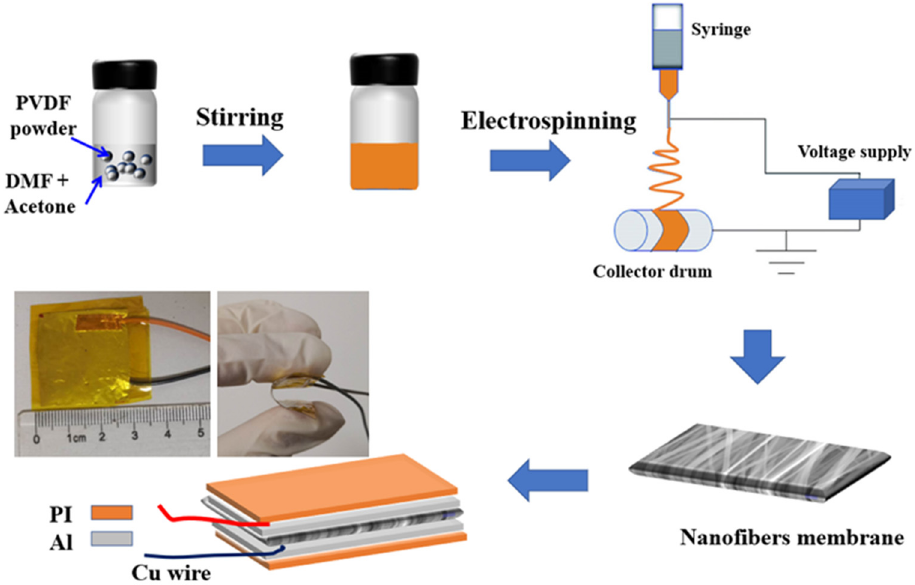
Figure 1. Schematic of step-wise fabrication of the nanogenerator and photographs of the flexible PVDF-based nanogenerator.